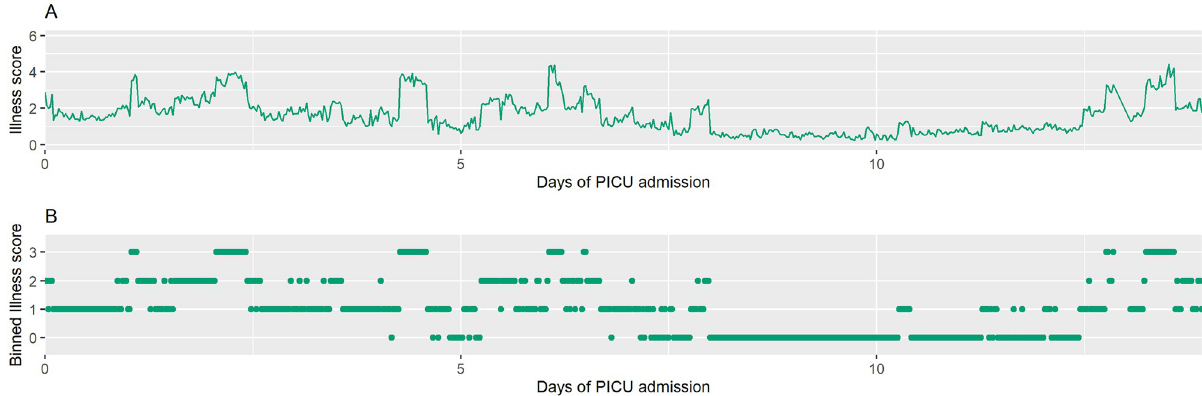
Fig 4. Time series of illness scores for patient 2. (A) Raw time series of illness scores for patient 2. (B) Time series with illness states sampled every 30 minutes and binned to create 4 discrete illness states (0–3). Patient 2 had 659 observed illness states, measured every 30 minutes, over a 14-day PICU admission. Patient 2 required mechanical ventilation for seven days. He had a relatively high entropy of 2.02 and a mean illness score of 1.6.